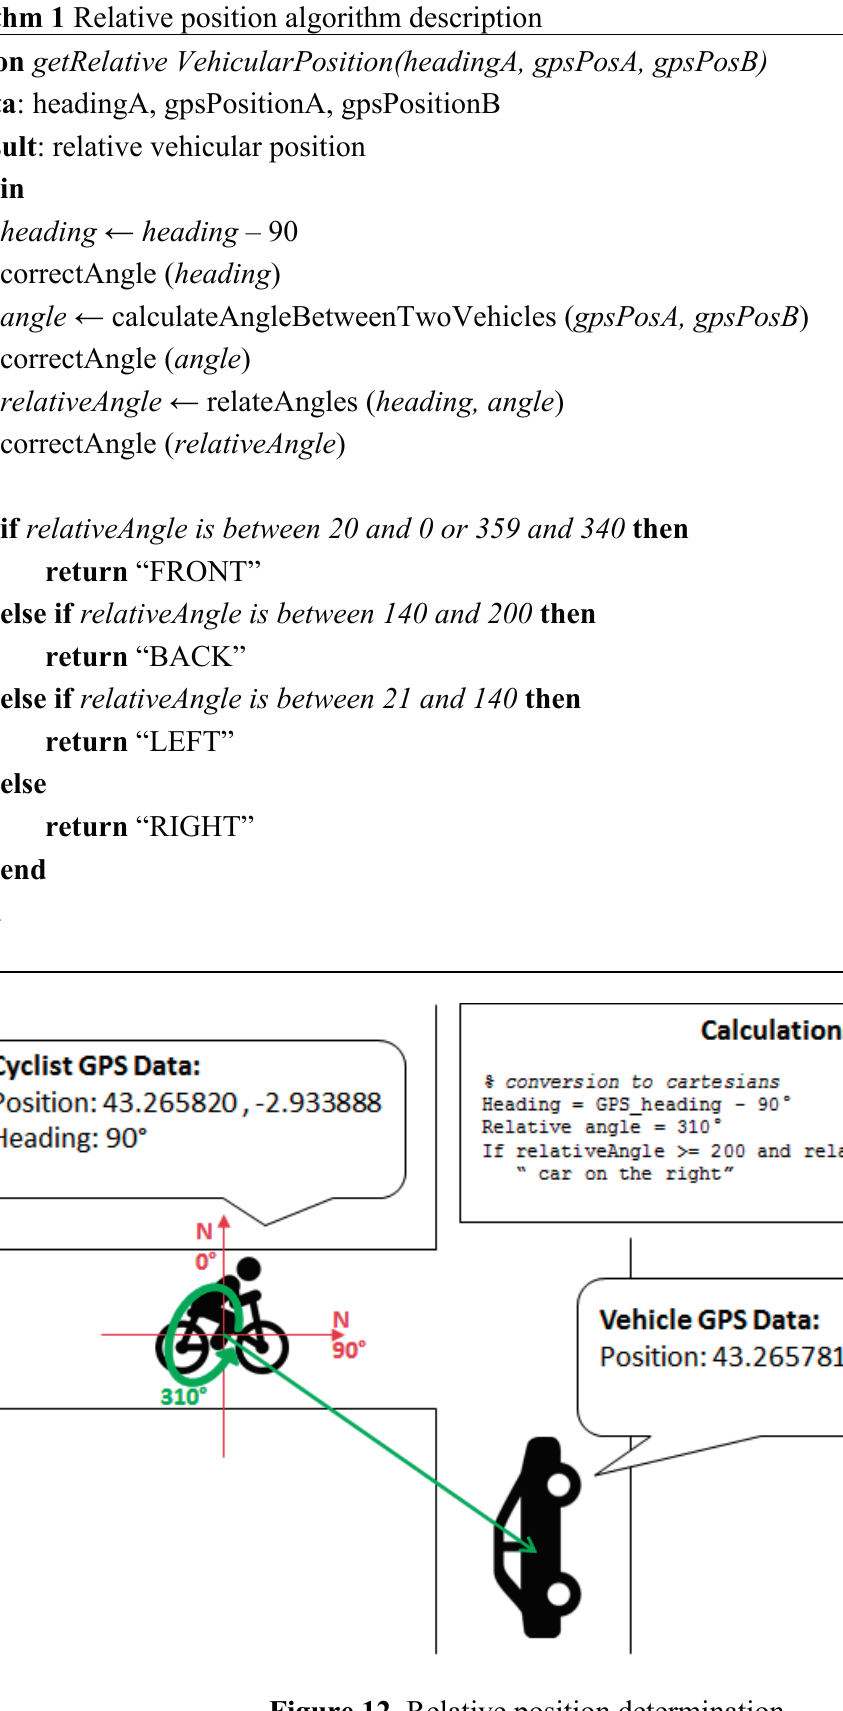
Figure 12. Relative position